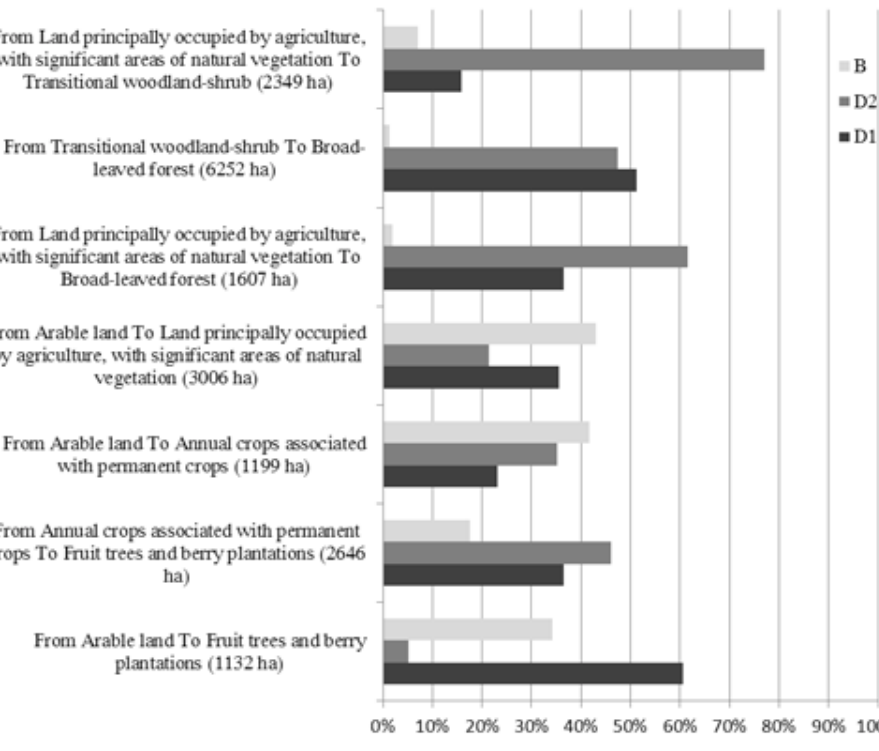
Figure 4. Distribution of “Baseline” scenario transitions (in brackets the areas that shifted from use u to